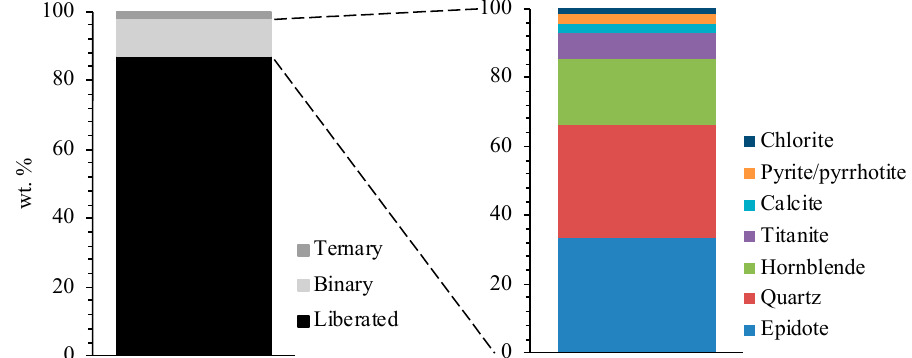
Figure 4. Mineral liberation of scheelite and association of non-liberated scheelite grains.